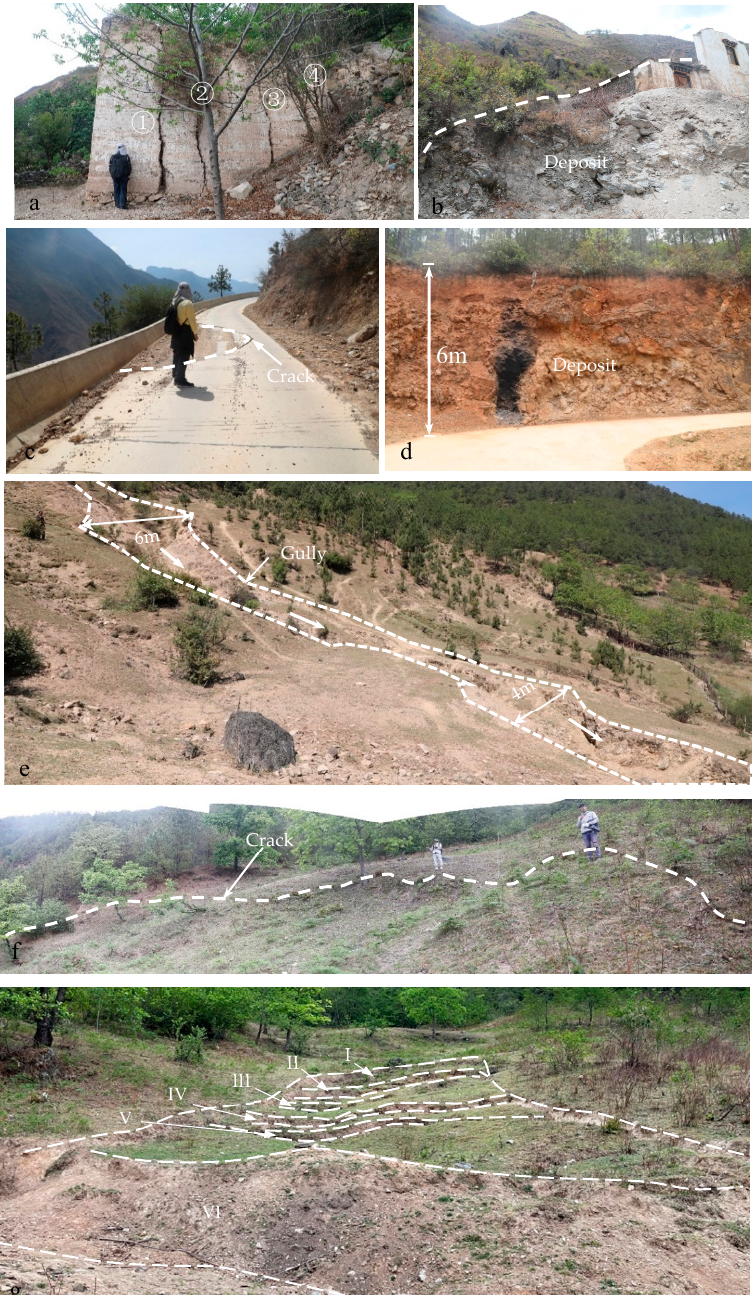
Figure 6. Field investigation of old landslide deposits. ( a ) Cracks on the surface of the house; ( b ) the downstream boundary of the deposit; ( c ) a small landslide in the free direction of the highway; ( d ) a typical section at the top of the downstream side of the KZG Village; ( e ) the gully between platform IV and platform V; ( f ) a tension crack in MP landslide; ( g ) a small soil landslide in MP